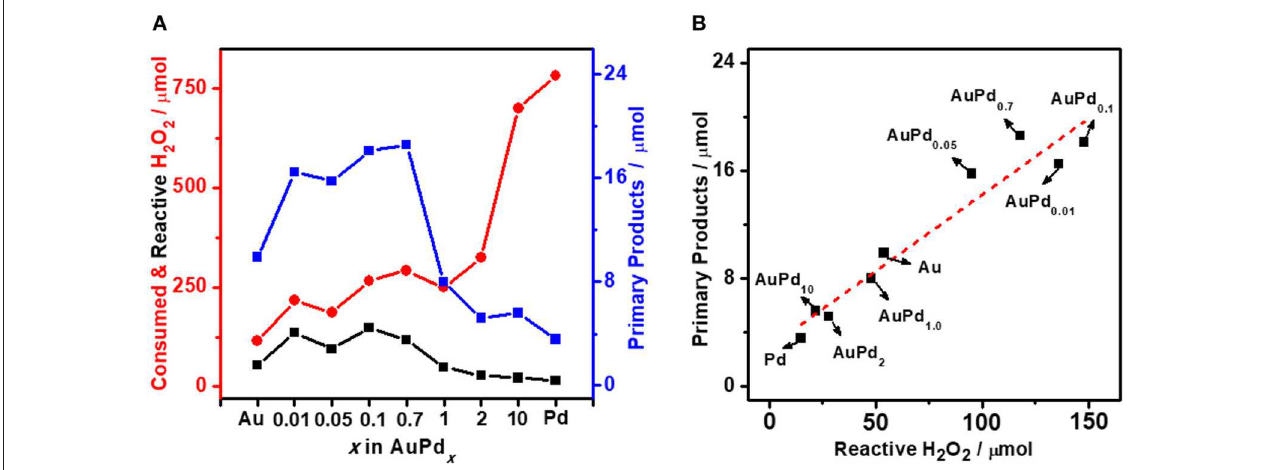
FIGURE 3 | (A) Methane oxidation reaction performance carried out with colloidal AuPd x nanoparticles. (B) Primary products as a function of reactive H 2 O 2 with various x (Au-to-Pd ratio). Reaction conditions: 3.0 MPa methane, 0.5 MPa O 2 , 1,000 µ mol H 2 O 2 , 50 ◦ C, 0.5h, initial pH = 3.0, 6.6 µ mol metal per